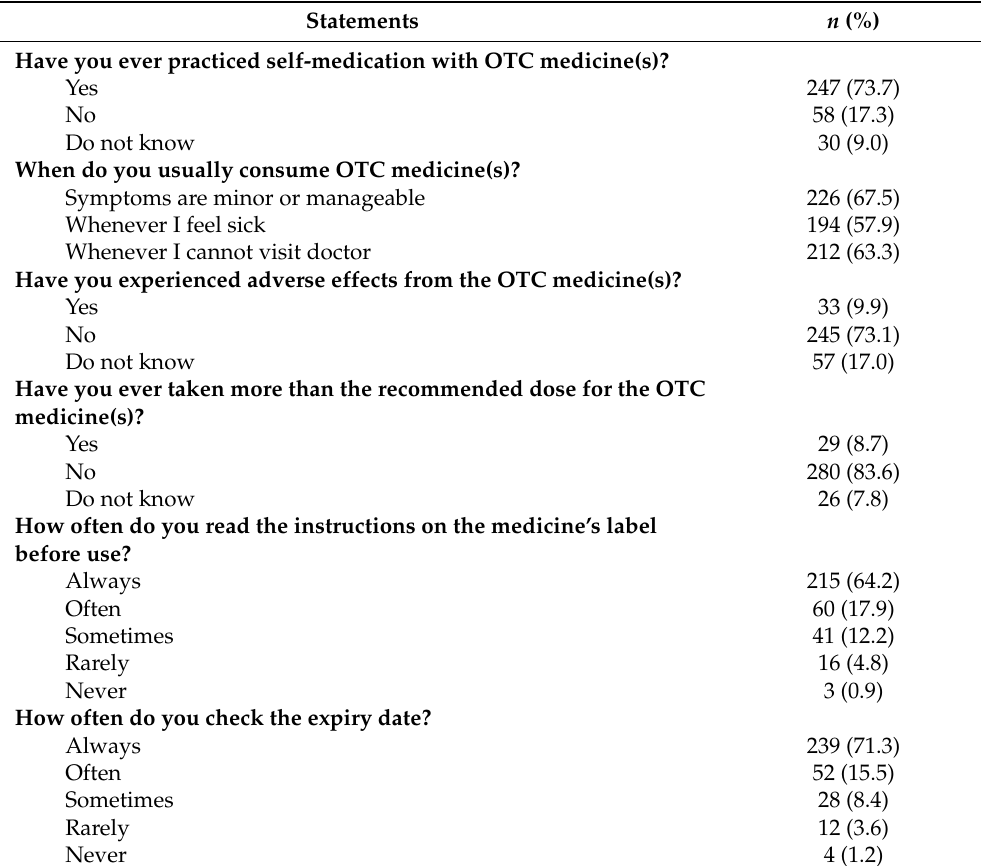
Table 5. Respondents’ actions on the use of OTC medicine.